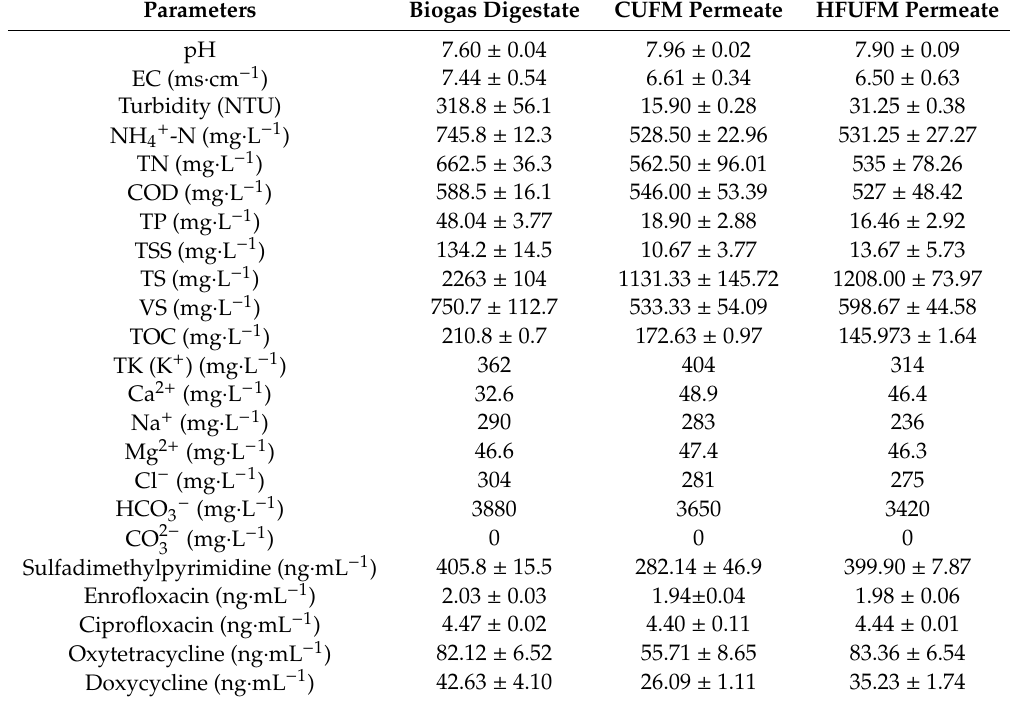
Table 4. The physico-chemical characteristics of the biogas digestate and the CUFM permeate and HFUFM permeate (mean ±